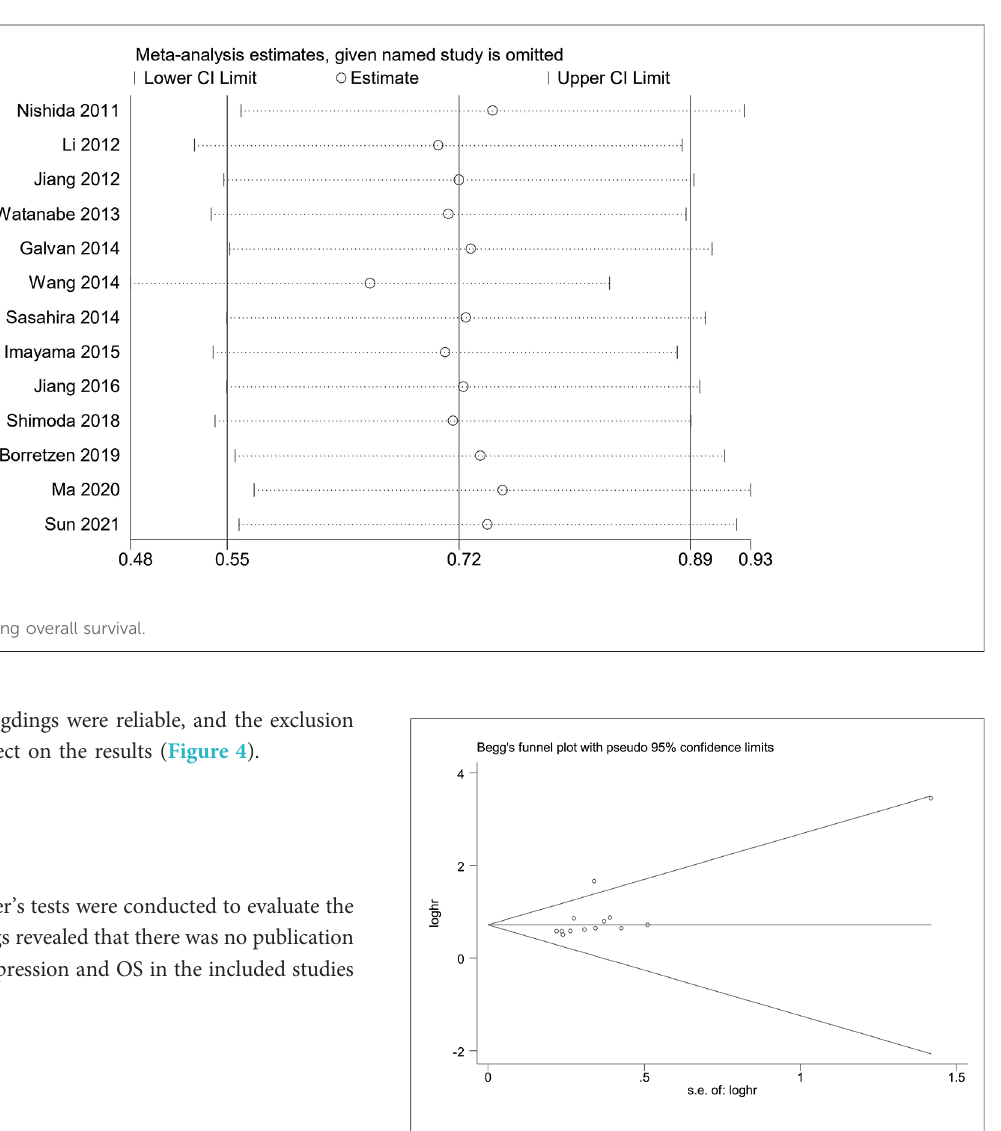
FIGURE 5 Publication bias in this